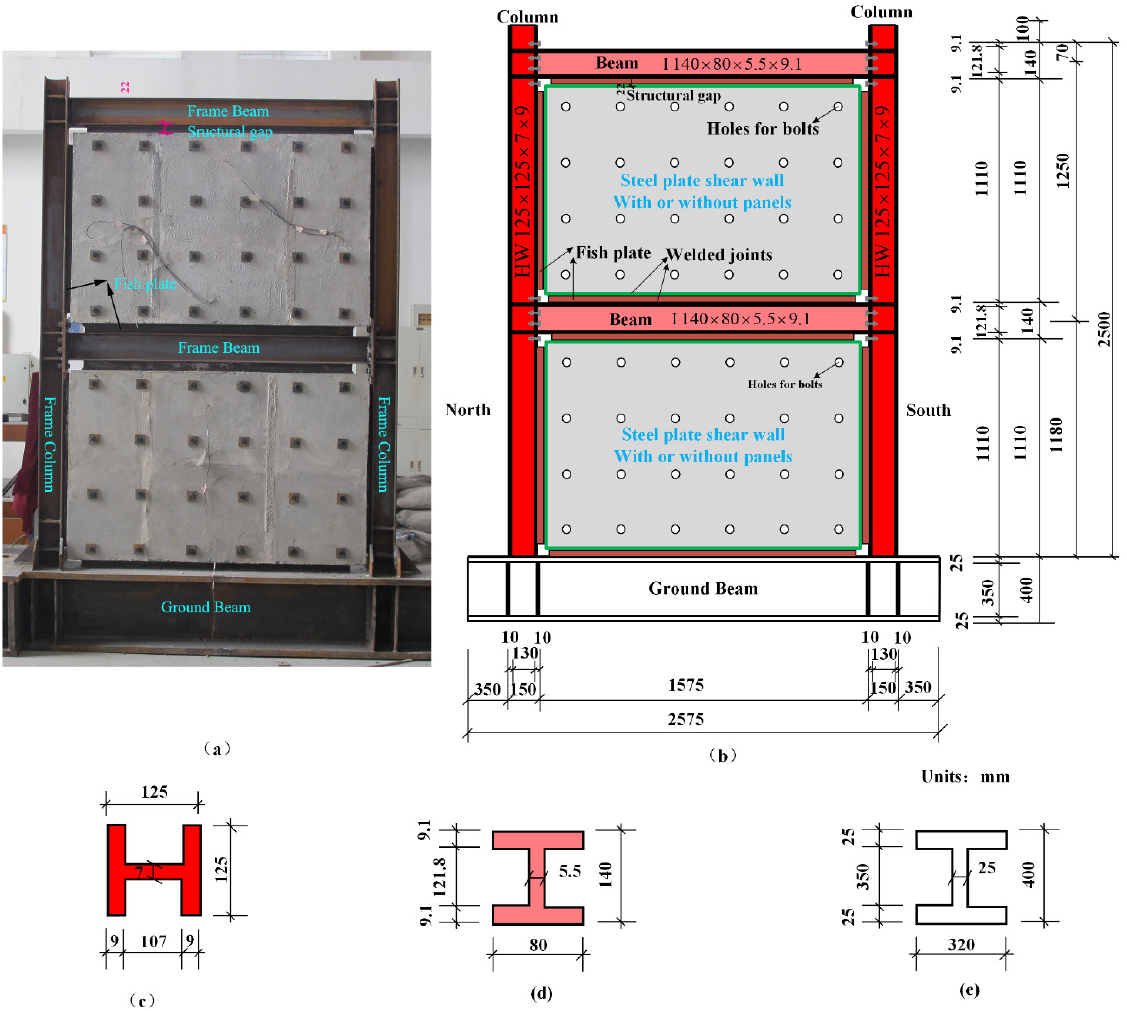
Figure 2. Dimensions of the steel frame: ( a ) tested specimen; ( b ) schematic diagram of tested specimen; ( c ) column; ( d ) beam; ( e ) ground beam.